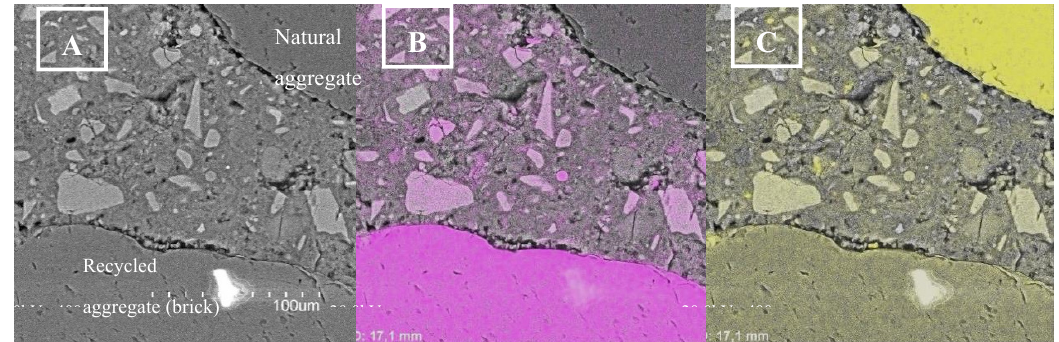
Figure 8. Elemental maps of recycled concrete: ( A ) Base image. ( B ) Elemental mapping for aluminium (magenta). ( C ) Elemental mapping for silicon (yellow).